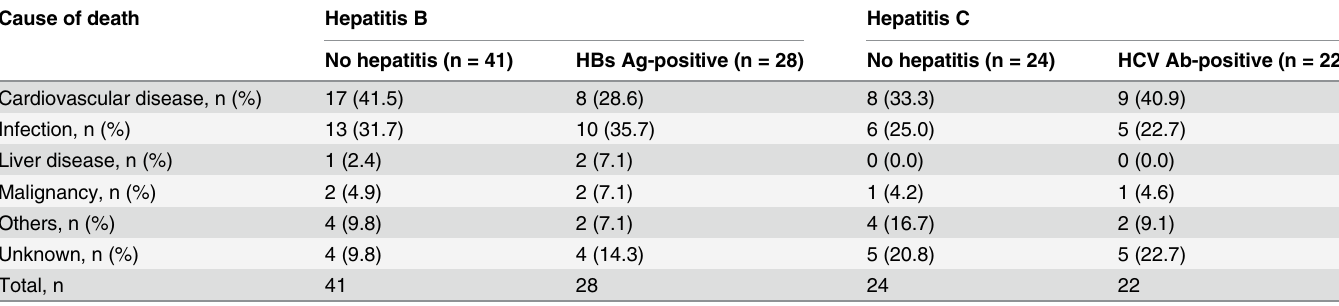
Table 3. Causes of death within the matched hepatitis B and C populations.